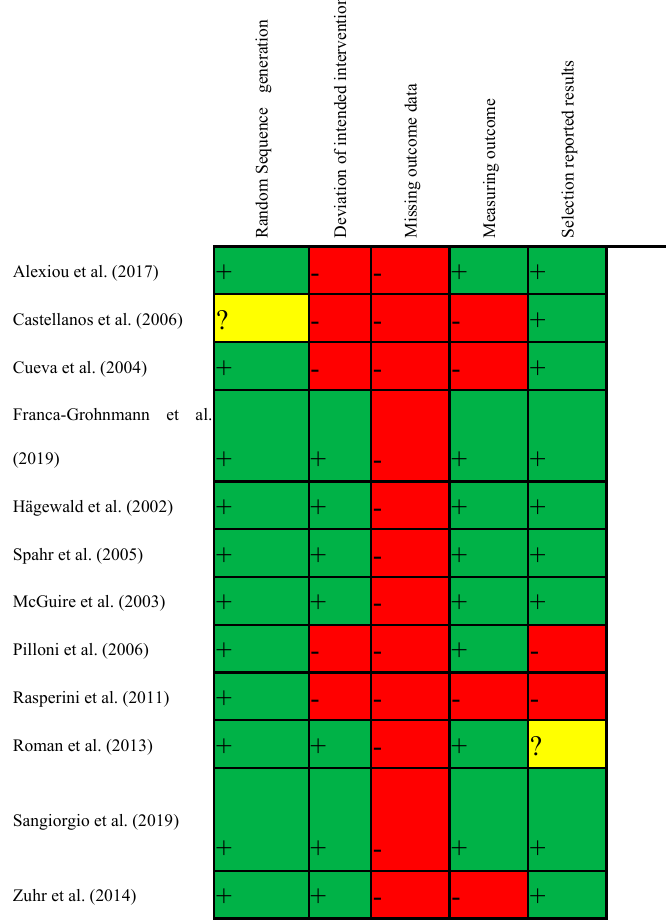
Figure 1. Cochrane risk for bias in individual